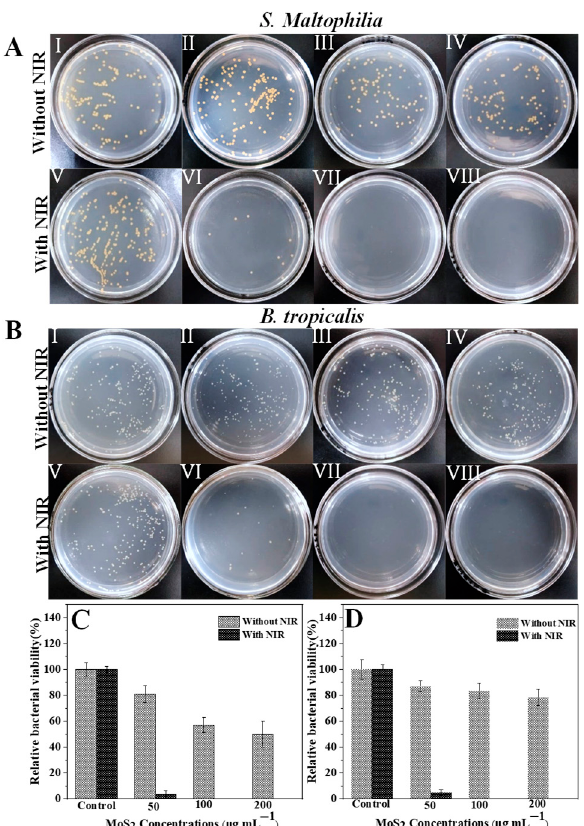
Figure 6. Photographs of bacterial colonies formed by ( A ) S. Maltophilia and ( B ) B. tropicalis after exposed to (I) PBS, (II) 50 µ g/mL PEG-MoS 2 NFs, (III) 100 µ g/mL PEG-MoS 2 NFs, (IV) 200 µ g/mL PEG-MoS 2 NFs, (V) PBS + NIR, (VI) 50 µ g/mL PEG-MoS 2 NFs + NIR, (VII) 100 µ g/mL PEG-MoS 2 NFs + NIR, (VIII) 200 μ g/mL PEG-MoS 2 NFs + NIR. The relative viability of ( C ) S. Maltophilia and ( D ) B. tropicalis after heat treatment with 808 nm NIR light for 10 min was measured by plate counting (Error bars are standard deviations of three parallel experiments).